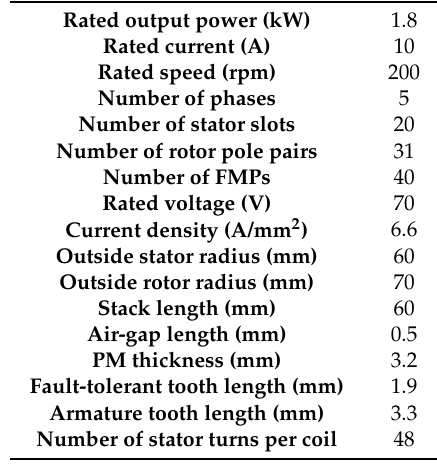
Figure 3. Short ‐ circuit current. Table 1. Motor parameters.